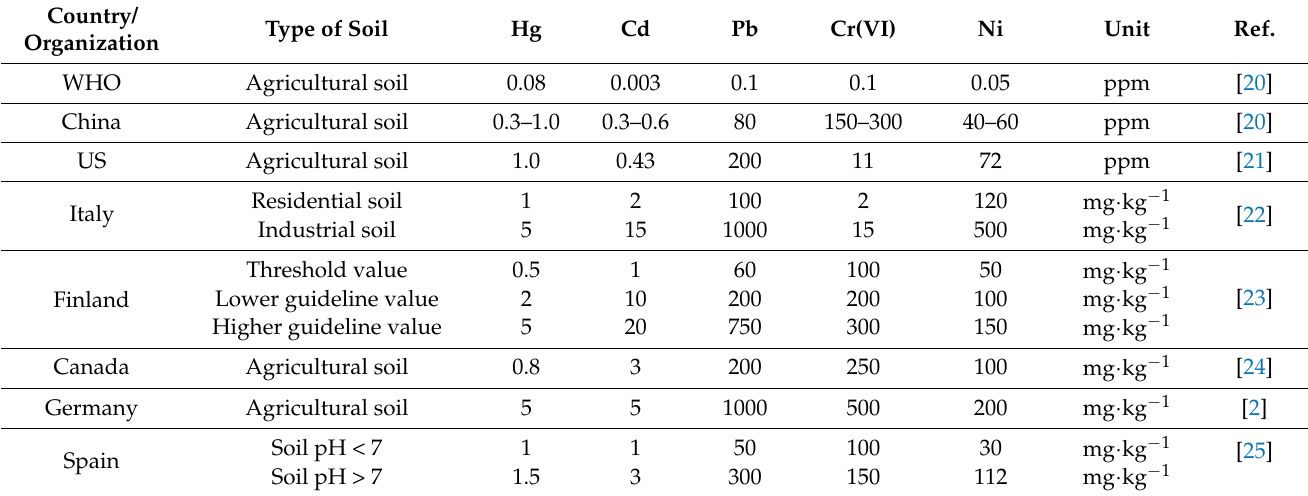
Table 2. Limit concentrations of heavy metals and metalloids in the